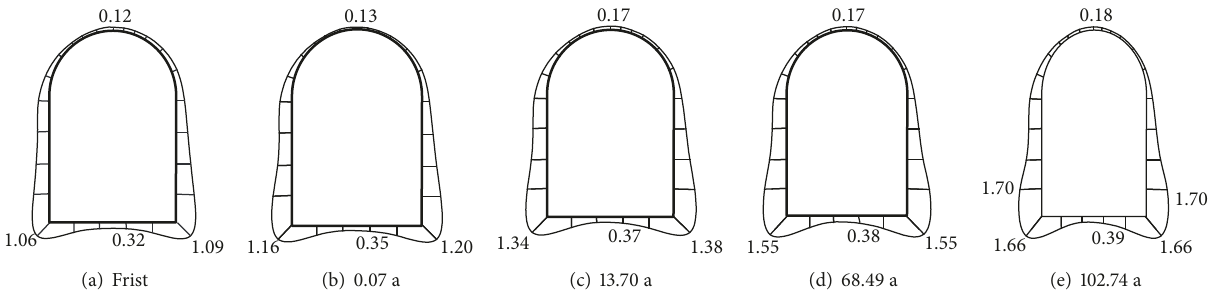
Figure 17: Maximum envelope of maximum principal stress at different operation times (MPa).